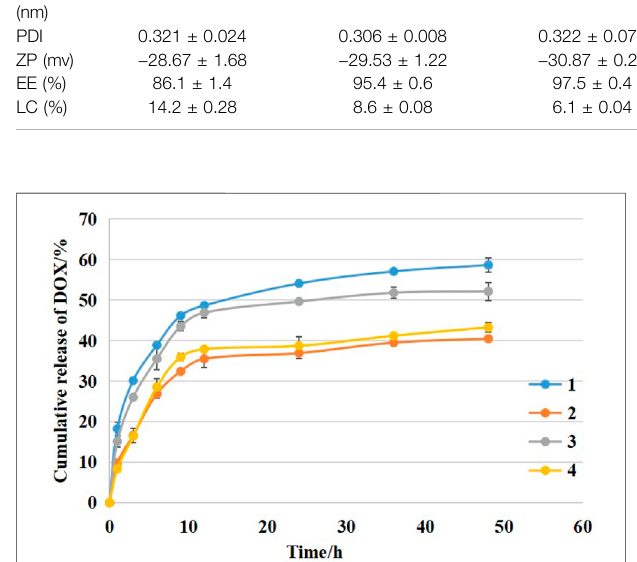
FIGURE 6 | The cumulative release kinetics of DOX from micelles: DSPE-PEG-C60: DOX= 10:1 (W/W) (1) , DSPE-PEG-C60: DOX= 15:1 (W/W) (2) ,DSPE-PEG-NH 2 :DOX=10:1(W/W) (3) ,andDSPE-PEG-NH 2 :DOX=15: 1 (W/W) (4) in PBS buffer (pH 7.4) at 37 °